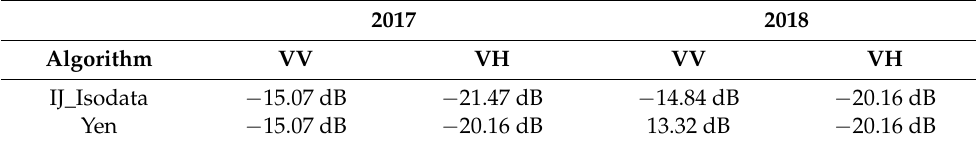
Table 2. Threshold values by algorithm and